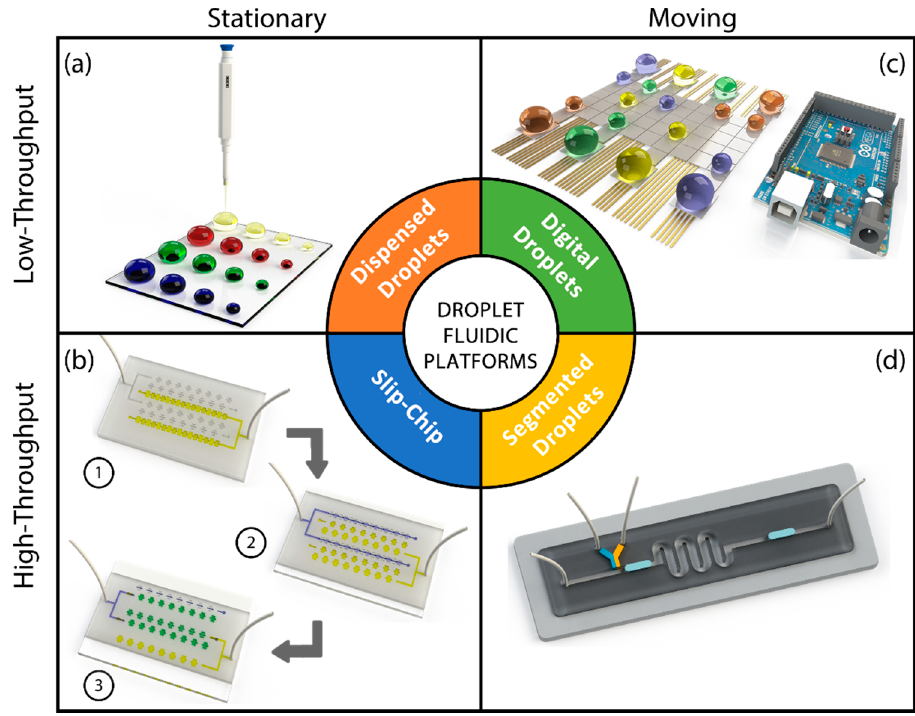
Figure 1. Various microfluidic droplet platforms: ( a ) dispensed droplets; ( b ) slip-chip; ( c ) digital droplets; ( d ) segmented flow droplets.